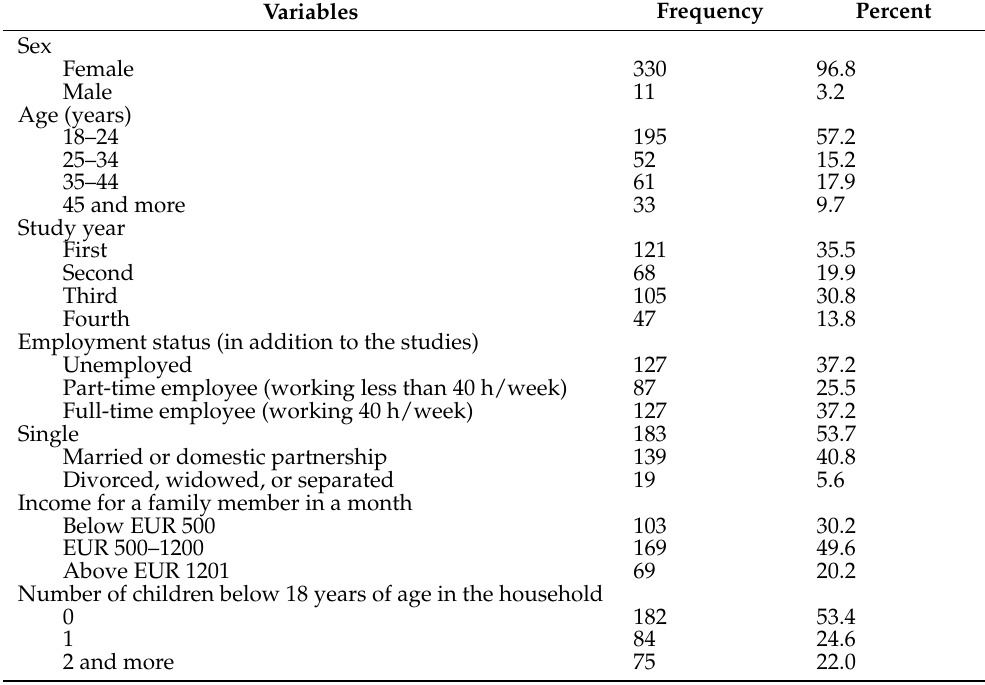
Table 1. Demographic characteristics of the study